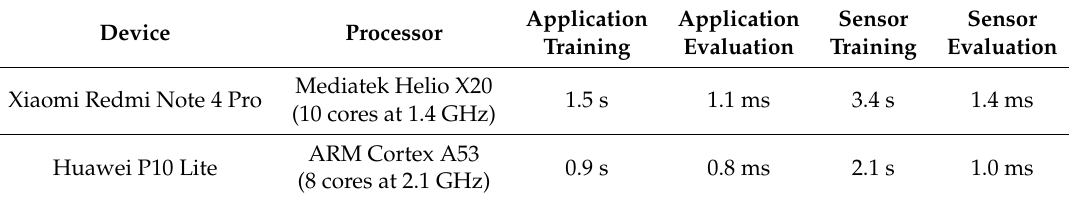
Table 10. Time consumption of our adaptive and continuous authentication